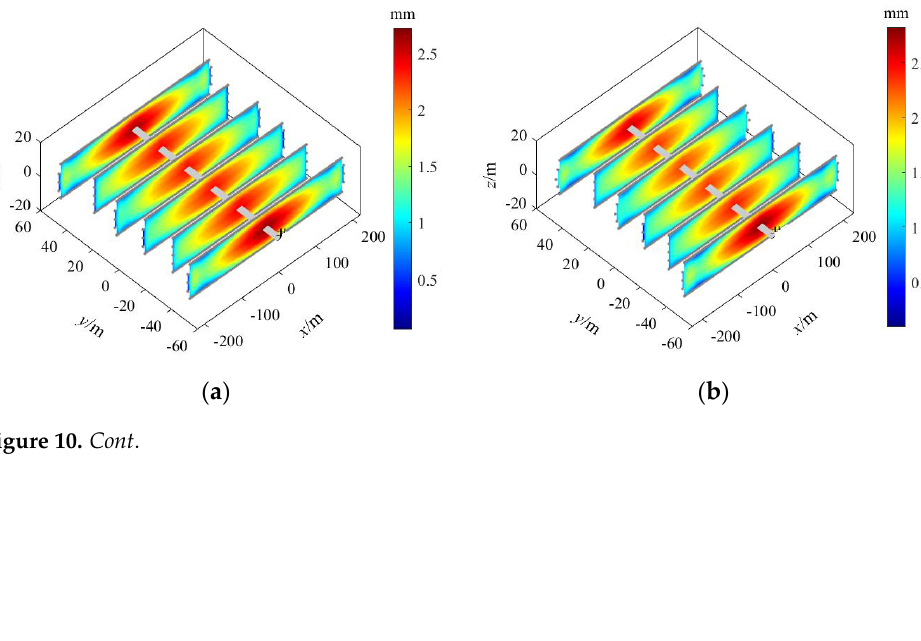
Figure 9. Liquid inflow difference of multiple clusters of fractures under different cluster numbers.